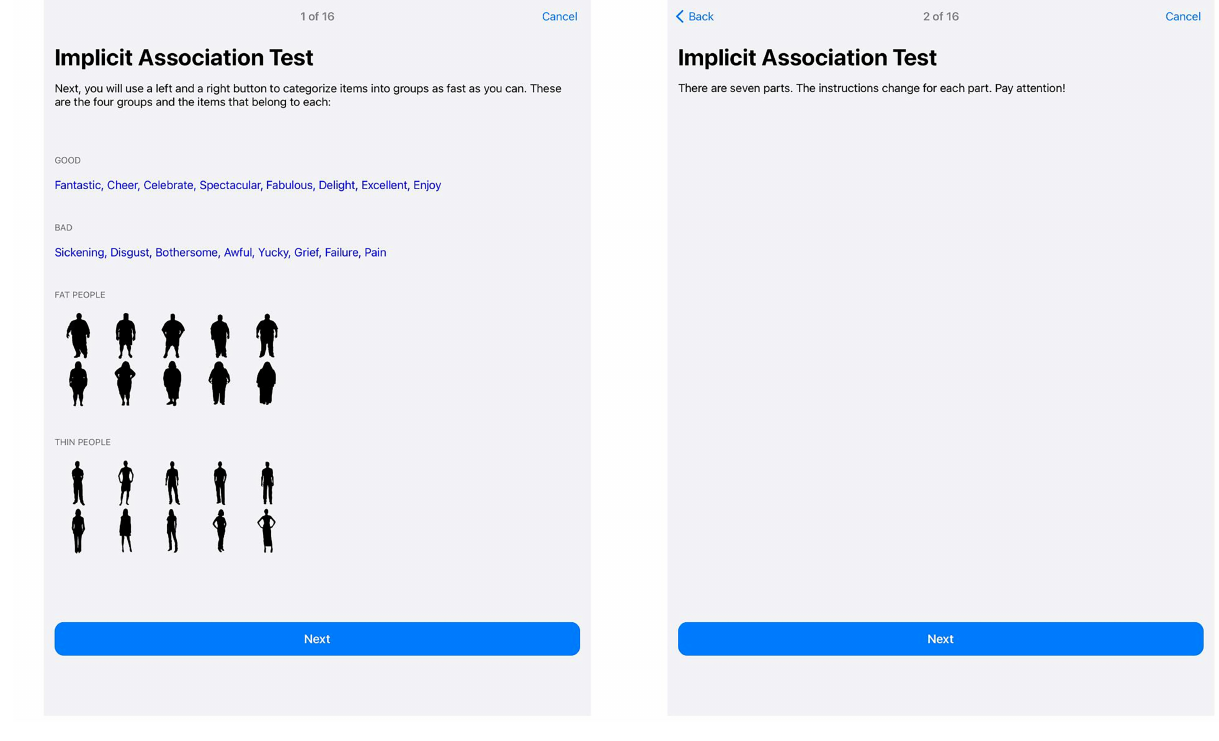
FIGURE 3 | Introduction to the concept and attribute stimuli (A) , as well as the basic structure of the IAT (B)